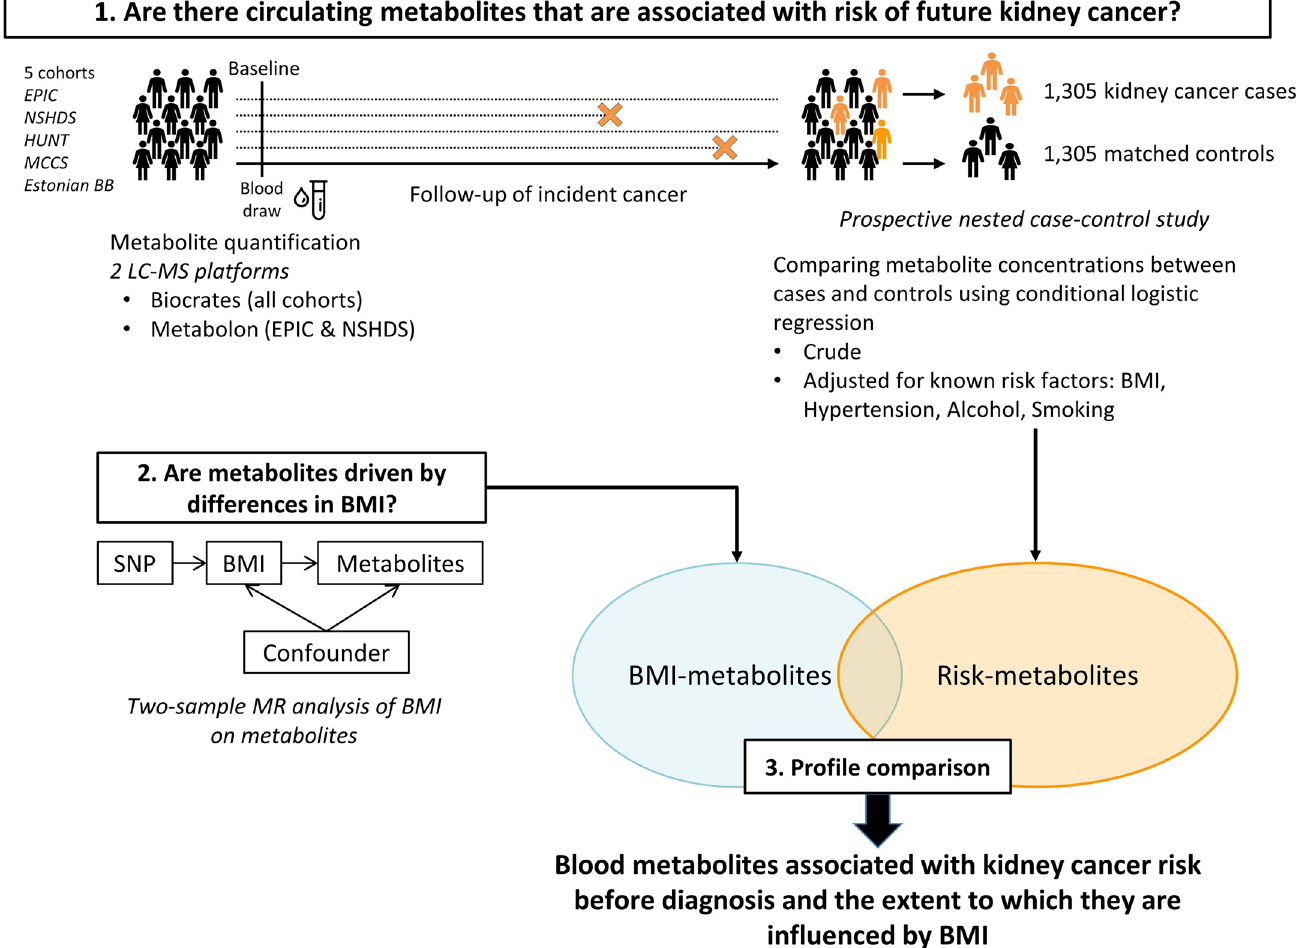
Fig 1. Conceptual framework of the study design. This study includes 3 main analytical steps: (i) the investigation of the associations between circulating levels of metabolites and kidney cancer risk using pre-diagnostic measurements in a case–control study nested within multiple large-scale prospective cohorts; (ii) the assessment of the causal effect of BMI, the leading modifiable risk factor for kidney cancer, on circulating metabolites levels; and (iii) the evaluation of the overlap between the metabolic footprint of BMI and that of kidney cancer risk. The orange X’s indicate the time at which a participant is diagnosed with kidney cancer when his follow-up is stopped. Controls have been selected among participants free of cancer at the time their matched case was diagnosed. Metabolites from all samples have been measured on the Biocrates platform, while only samples from EPIC and NSHDS cohorts have been measured with Metabolon platform. BMI, body mass index; EPIC, The European Prospective Investigation into Cancer and Nutrition; Estonian BB, University of Tartu—Estonian Biobank; HUNT, The Tr ø ndelag Health Study; LC–MS, liquid chromatography–tandem mass spectrometry; MCCS, The Melbourne Collaborative Cohort Study; MR, mendelian randomisation; NSHDS, Northern Sweden Health and Disease study; SNP, single nucleotide polymorphism.